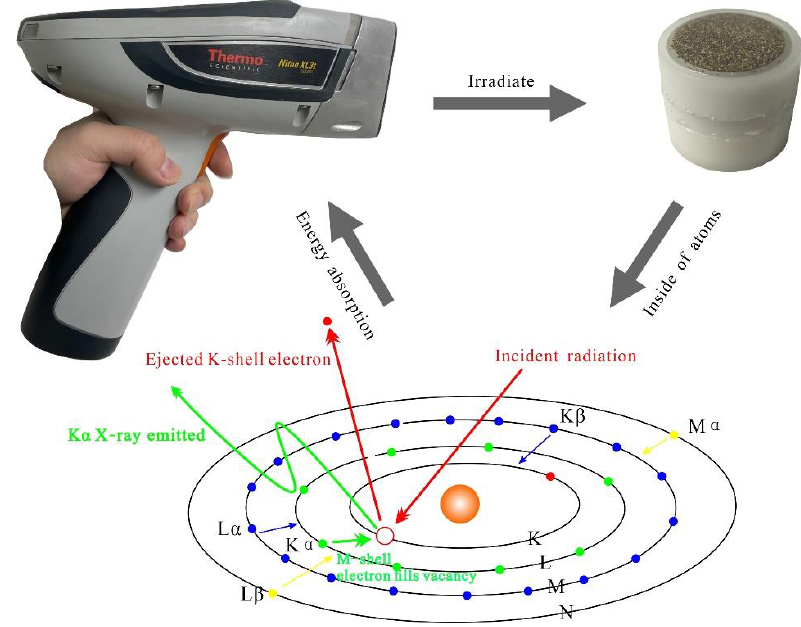
Figure 3. Principle of pXRF instrument.